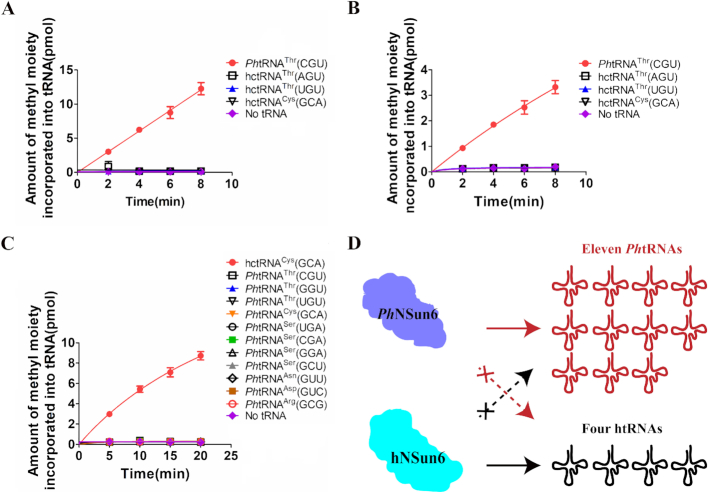

PhNSun6 or hNSun6 discriminates the cognate tRNA substrates. The capacity of PhtRNAThr(CGU) and three hctRNAs to be methylated by PhNSun6 at 65°C (A) or 55°C (B). (C) The capacity of hctRNACys(GCA) and eleven PhtRNAs to be methylated by hNSun6. Error bars represent the standard errors of three independent experiments. (D) Schema showing that PhNSun6 or hNSun6 could only methylate the cognate tRNA substrates.